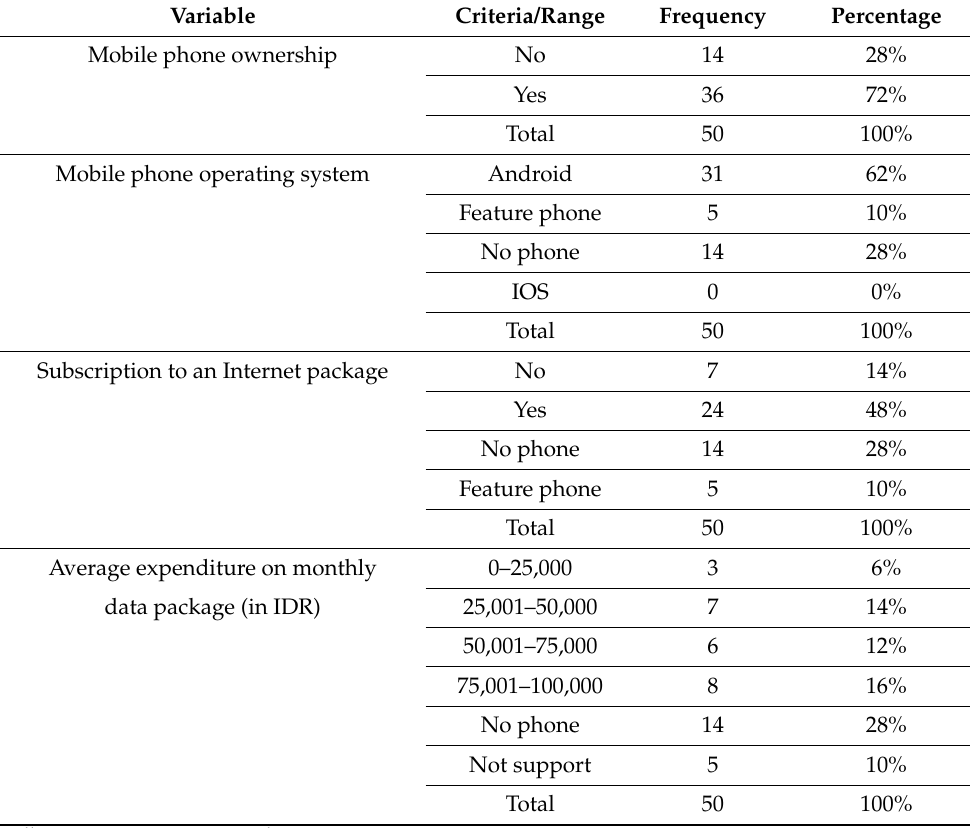
Table 2. Mobile phone ownership of smallholder chili farmers in Sukabumi and Bandung Barat